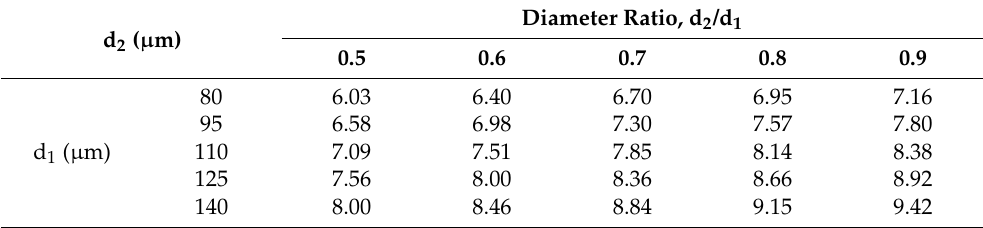
Table 4. Neck radius for the SET A of simulations measured at the end of the